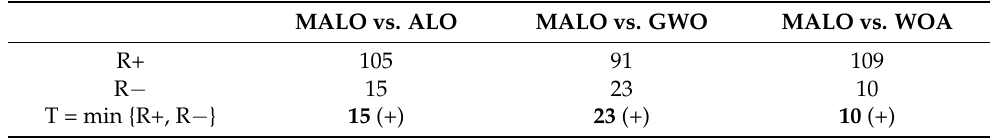
Table 15. The t values of significance test on averaged accuracy between MALO VS. ALO, MALO vs. GWO, and MALO vs.